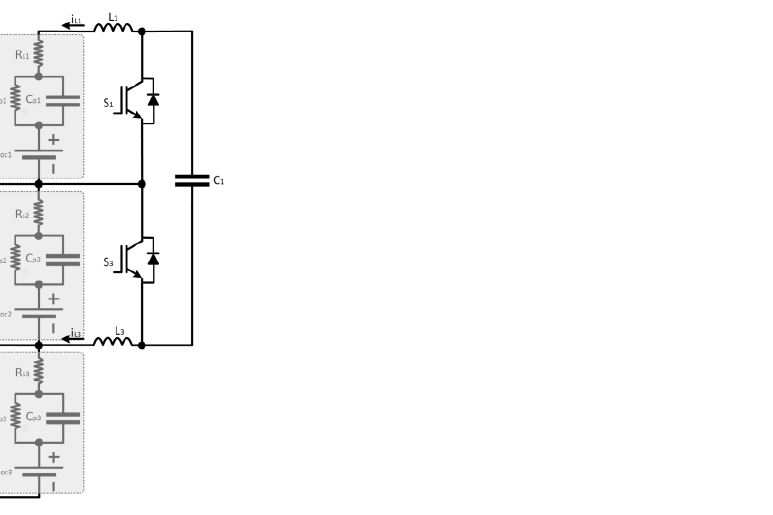
Figure 14. Cuk converter.